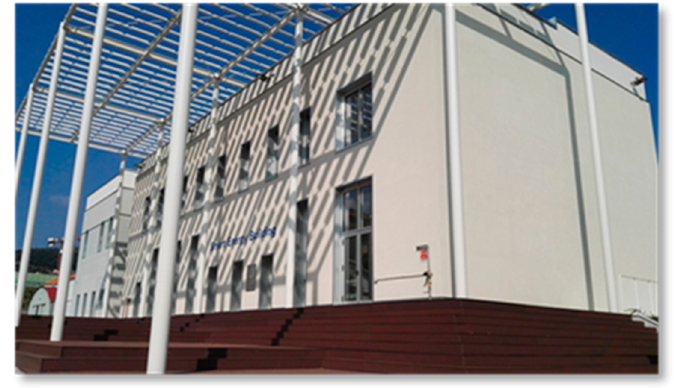
Figure 4. The Smart Energy Building.